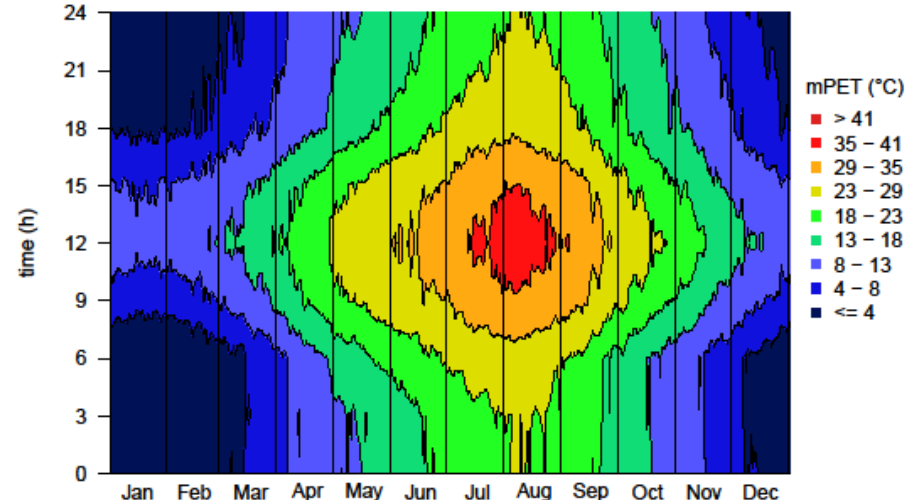
Figure 8. Temporal diagram for mPET for Tokyo during the period August 1966 to June 2018 (3 h resolution). The reference height for the results is 1.1 m. The sensation classes are defined in Table 2. The variation throughout the day can be seen in y-direction, while the variation over the year is given in x-direction.